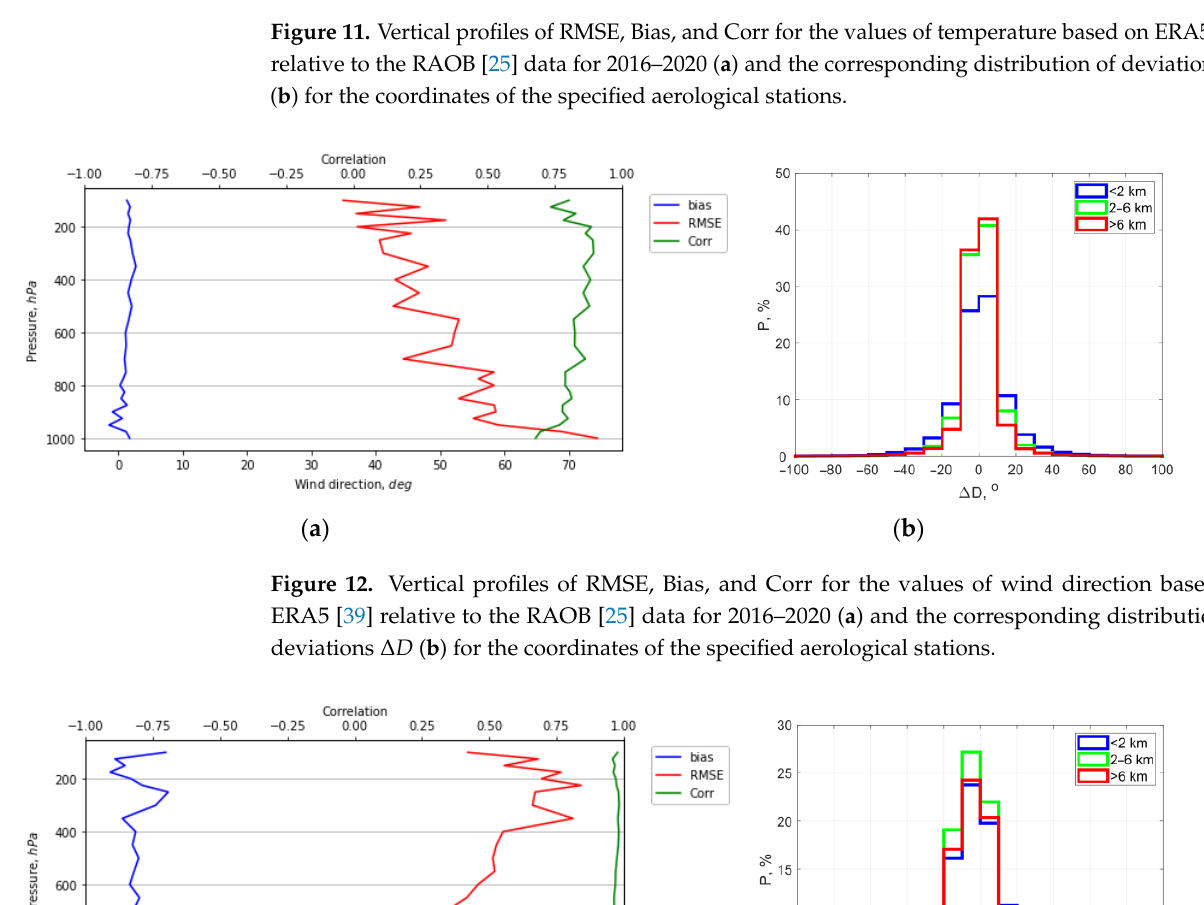
Figure 11. Vertical profiles of RMSE, Bias, and Corr for the values of temperature based on ERA5 [39] relative to the RAOB [25] data for 2016–2020 ( a ) and the corresponding distribution of devia-